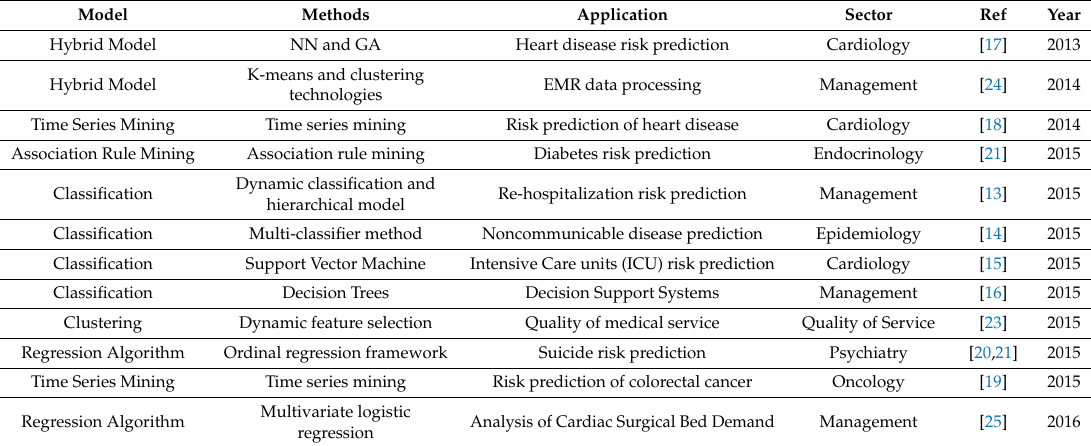
Table 1. Example of data mining (DM) case studies from